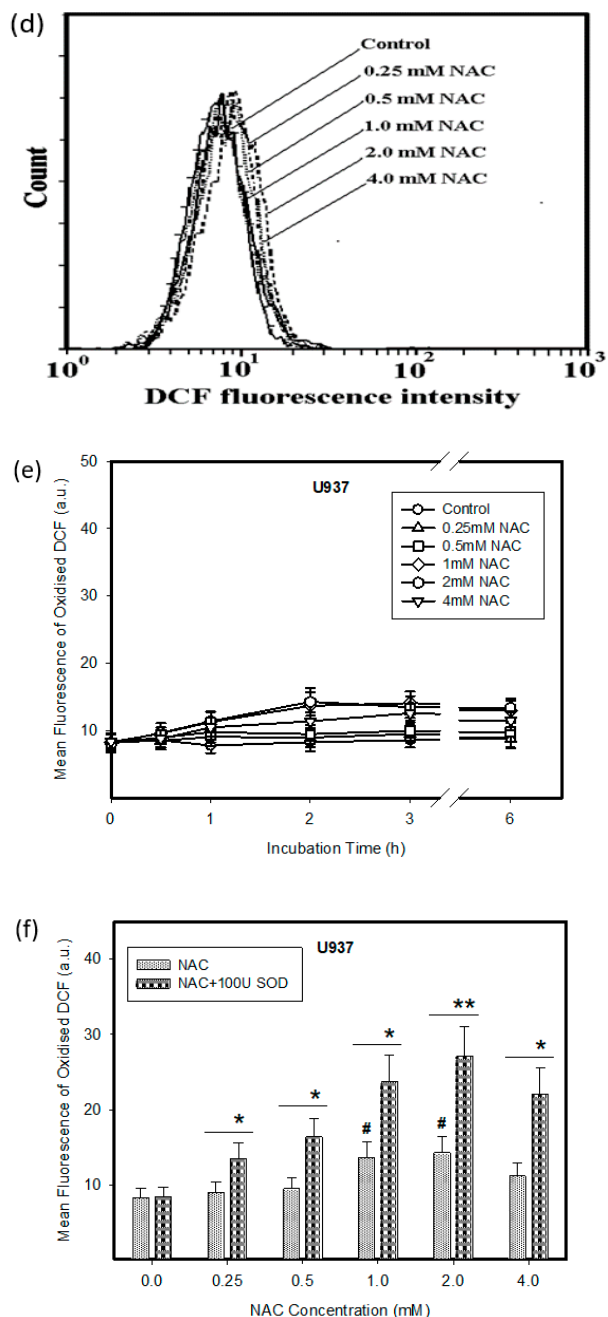
Figure 2. Effect of NAC on ROS production in HL-60 and U937 cells. Cells were treated with NAC as indicated. After the indicated period, the incubation cells were stained with H 2 DCF-DA and fluorescence intensity was analyzed using flow cytometry. ( a ) Effect of NAC on ROS production in HL-60 cells (a typical analysis). ( b ) Time course of ROS production in NAC treated HL-60 cells. ( c ) Effect of SOD on ROS production in NAC treated HL-60 cells. Points represent mean value from three independent experiments with standard errors. ( d ) Effect of NAC on ROS production in U937 cells (a typical analysis). ( e ) Time course of ROS production in NAC treated U937 cells. ( f ) Effect of SOD on ROS production in NAC treated U937 cells. Points represent mean value from three independent experiments with standard errors. # / ## denotes significant/very significant difference in the mean fluorescence of oxidized DCF ( p < 0.05/ p < 0.01) between the NAC treated and untreated (control) cells. */** denotes significant/very significant difference in the mean fluorescence of oxidized DCF ( p < 0.05/ p < 0.01) between the indicated